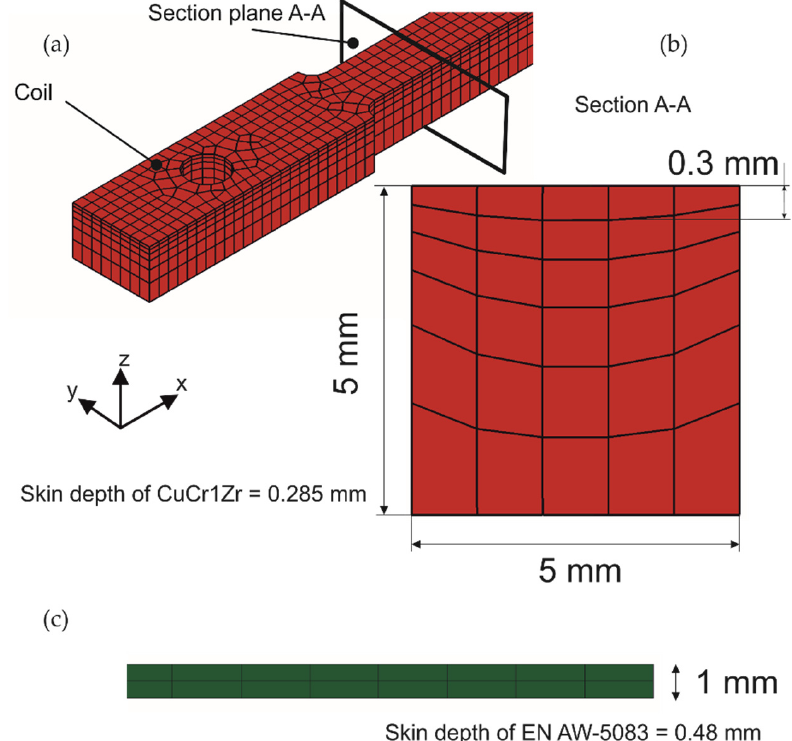
Figure 4. Meshing of the coil for the numerical model. ( a ) View of the coil end and the hole feature; ( b ) cross-sectional view showing thinner top element layers ( c ) cross-sectional view showing thickness-elements of the workpiece.